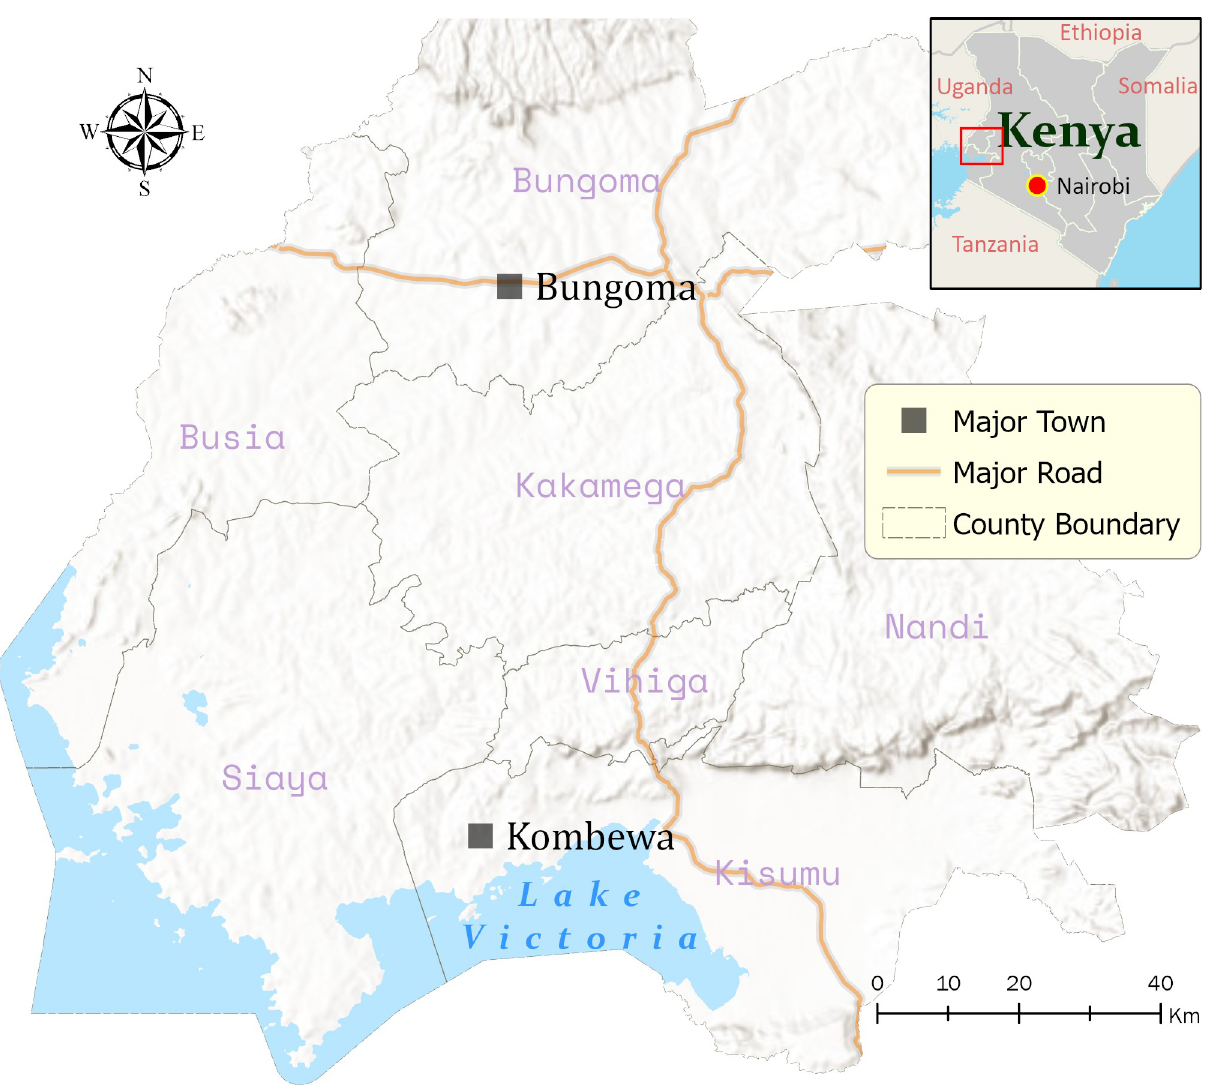
Fig 1. Map of the study areas in western Kenya. The map was generated using ArcGIS Pro 2.6 software. Map source: ESRI, CGIAR, and USGS (available at: www.esri.com).